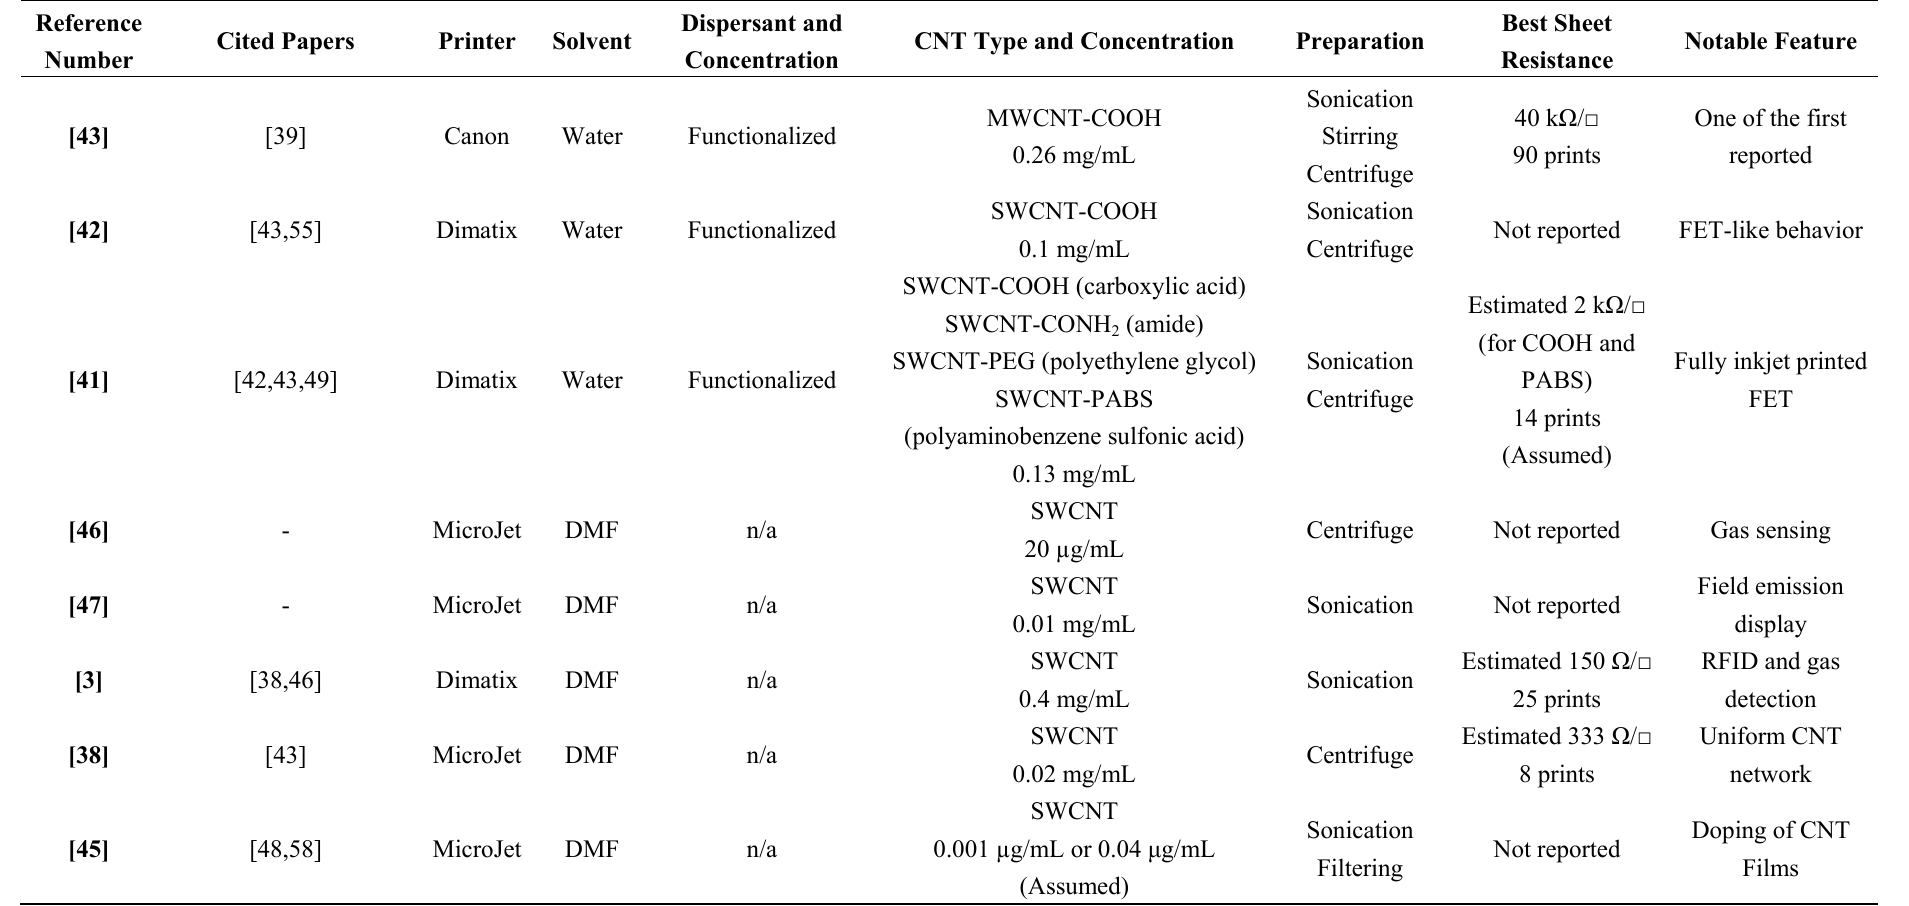
Table 1. Comprehensive comparison of recently reported carbon nanotube